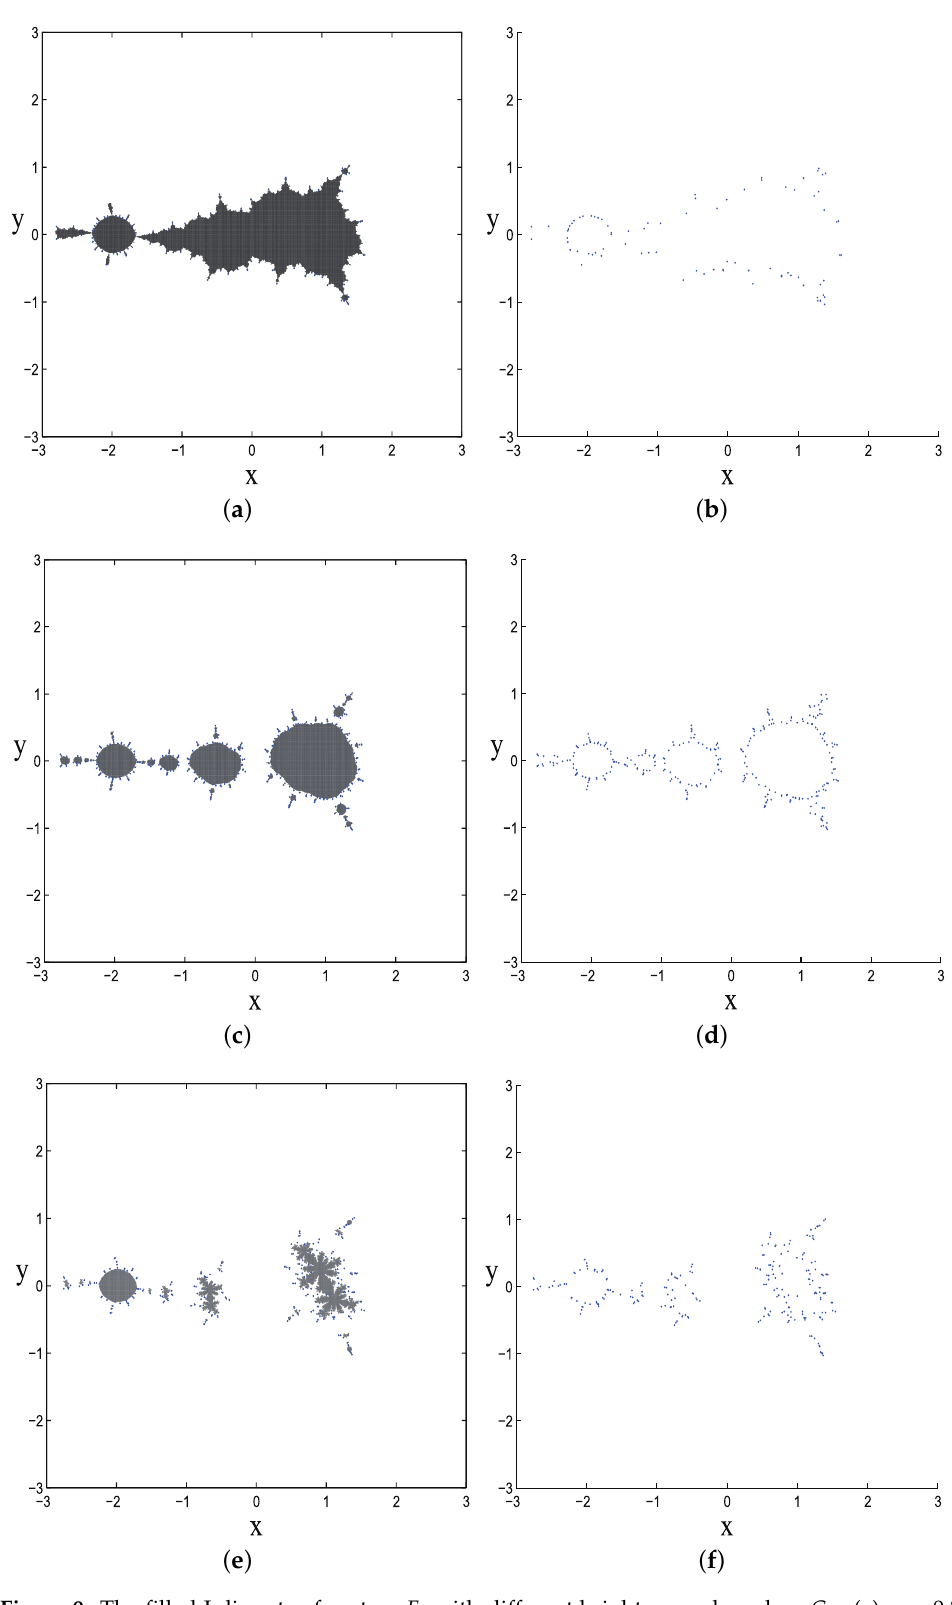
Figure 9. The filled Julia sets of system F 2 with different brightnesses based on Co . ( a ) a = 0.3 + 0.02 i , ( c ) a = 0.324 + 0.01 i , ( e ). a = 1/3 + 83 i /2000. ( b , d , f ): Separate the points ς p ,1 corresponding to ( a , c , e ).